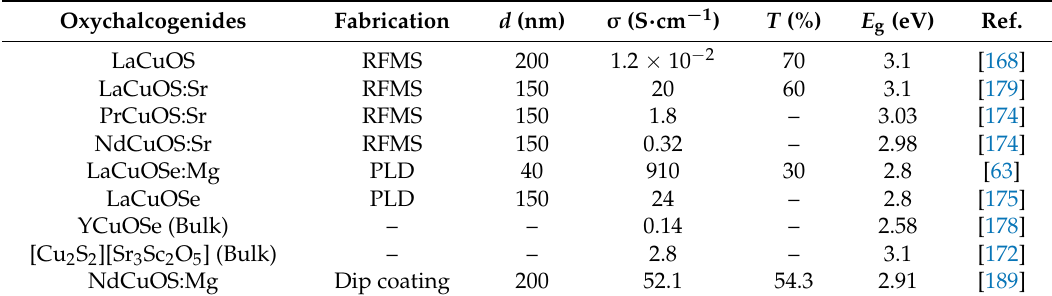
Table 2. Summary of selected oxychalcogenides with their material properties including thickness ( d ), conductivity ( σ ), transmittance ( T ), and optical band gap ( E g